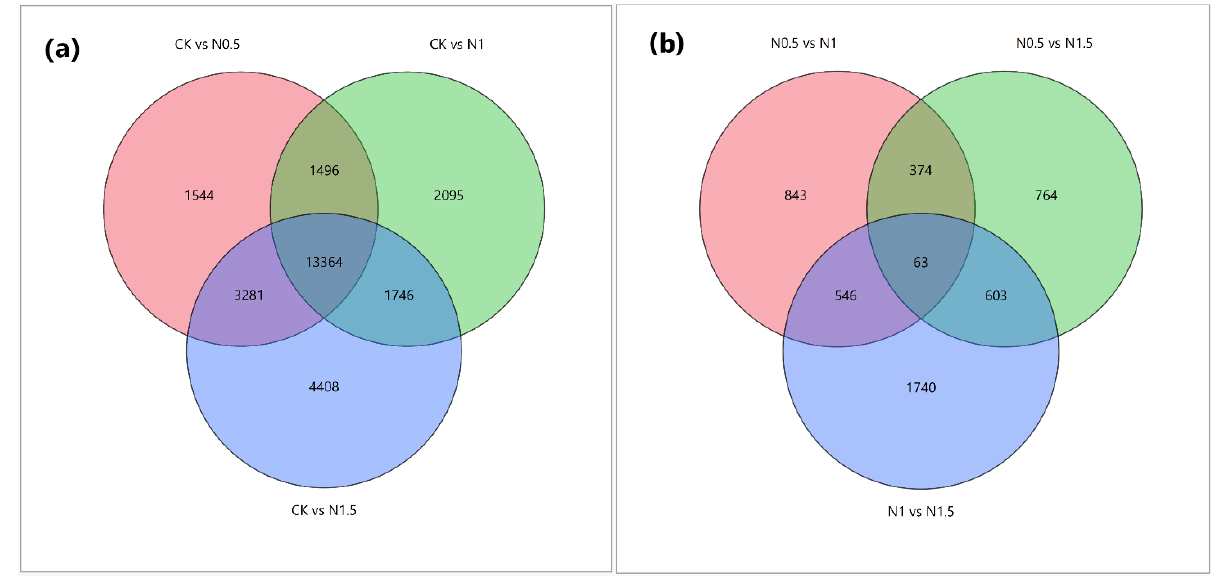
Figure 4. Venn diagrams illustrating the differentially expressed genes. The sum of the numbers in each circle represents the total number of expressed genes within a comparison. In contrast, the numbers in the overlapping areas represent the number of expressed genes shared ( a ) between the CK and treatment comparison groups and ( b ) between different treatment comparison groups of cotton seedlings. CK: no treatment; N0.5: NaCl treatment for 0.5 h, N1: NaCl treatment for 1 h, and N1.5: NaCl treatment for 1.5 h.